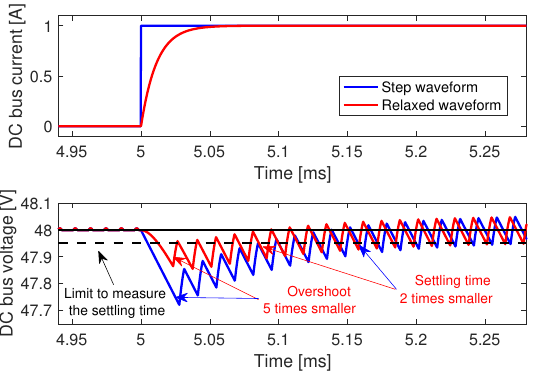
Figure 18. Behavior of the proposed SMC for both step and relaxed current